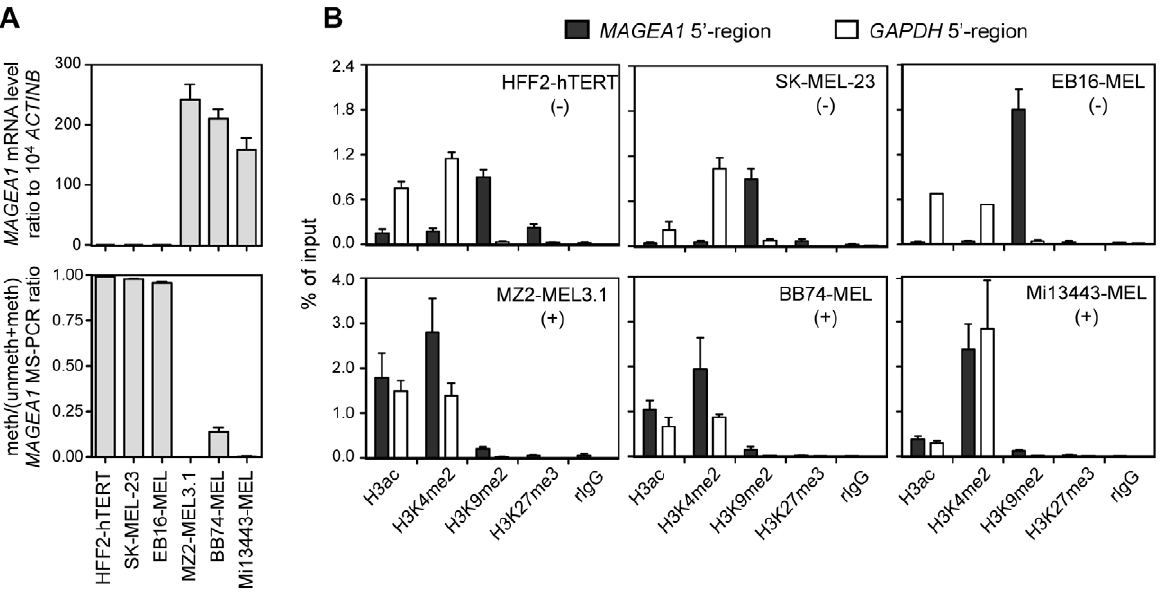
Figure 1. Histone changes associated with the activation of gene MAGEA1 in melanoma cell lines. A , MAGEA1 mRNA expression levels (upper panel) and 5 9 -region DNA methylation levels (lower panel) were evaluated in three non-expressing cell lines (HFF2-hTERT, SK-MEL-23 and EB16-MEL) as well as in three expressing cell lines (MZ2-MEL3.1, BB74-MEL and Mi13443-MEL). Values represent the mean ( 6 sem) of two independent qRT-PCR or qMS-PCR experiments, each in duplicate. B , ChIP-quantitative PCR was applied to the same cell lines to evaluate enrichment of the indicated histone modifications within either the MAGEA1 5 9 -region or the GAPDH promoter (representing a ubiquitously active promoter). Data derive from at least two independent ChIP experiments, with two duplicate qPCR measures in each case.